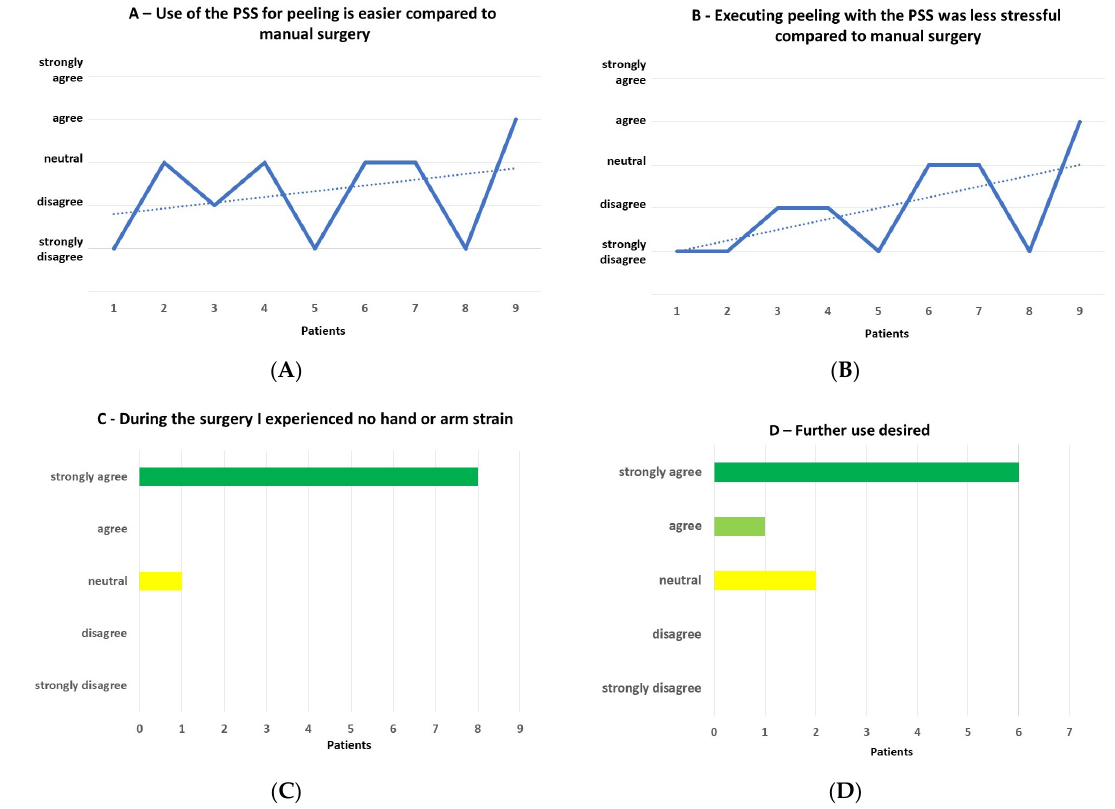
Figure 4. ( A ) Use of the PSS for peeling is easier compared to manual peeling. ( B ) Executing peeling with the PSS was less stressful compared to manual surgery. While the solid lines connect the re- sponses after each case, the dashed lines present a trend line indicating easier handling and less stress over time. ( C ) During the surgery, I experienced no hand or arm strain. ( D ) Further use de- sired.